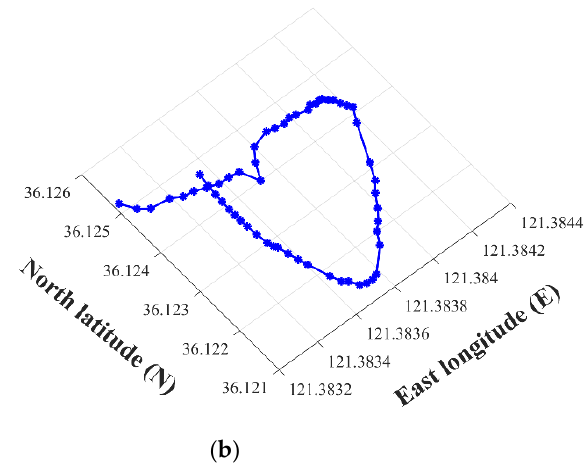
Figure 34. The trajectories of the two “ Black Pearl ” wave gliders. ( a ) The trajectory with the SALL submerged glider; and ( b ) the trajectory with the conventional submerged glider.